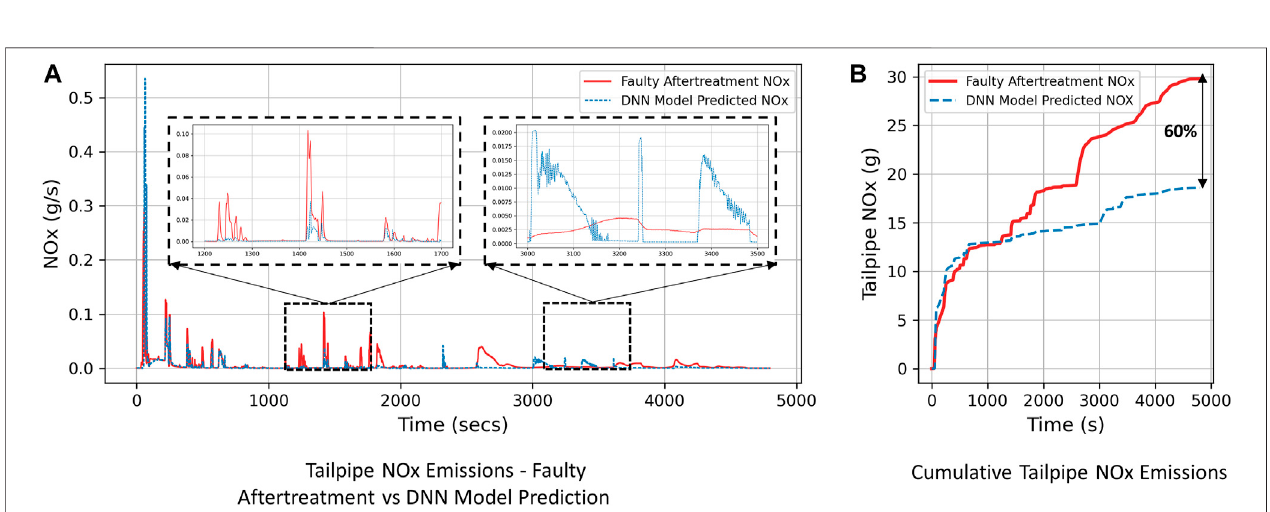
FIGURE 11 | Application of DNN for fault detection in SCR aftertreatment Systems. (A) Tailpipe NOx Emission-faulty after treatment vs DNN model prediction. (B) Cumulative Tailpipe NOx Emission.